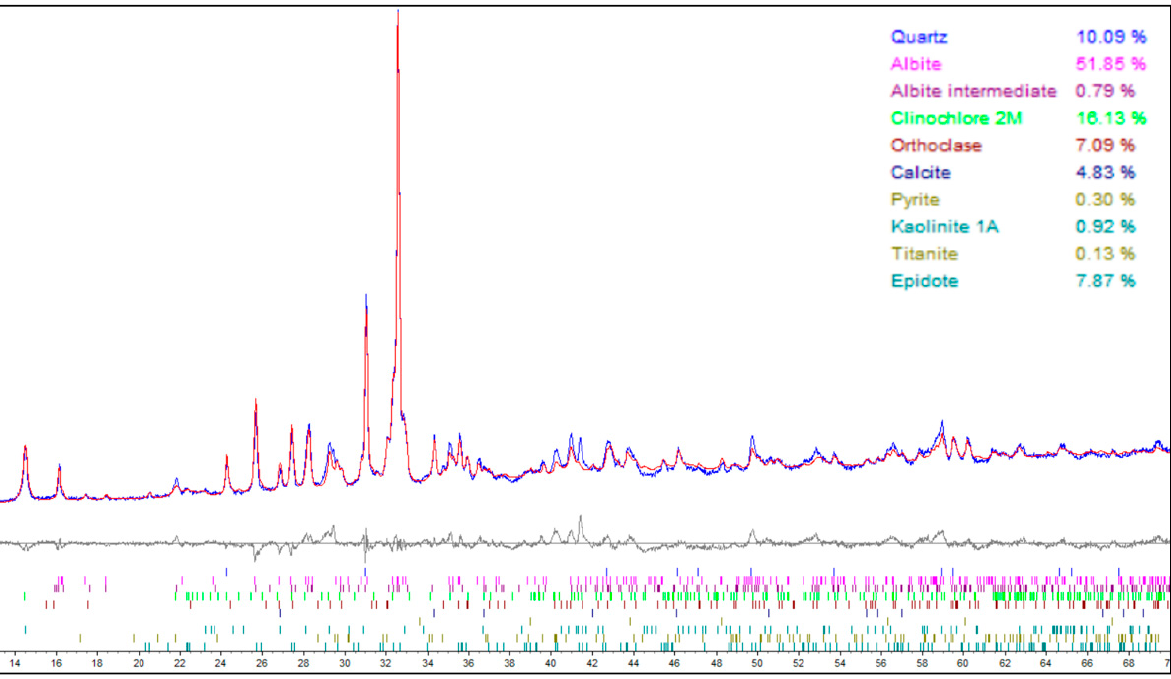
Figure 2. XRD pattern of un ‐ reacted copper tailings.